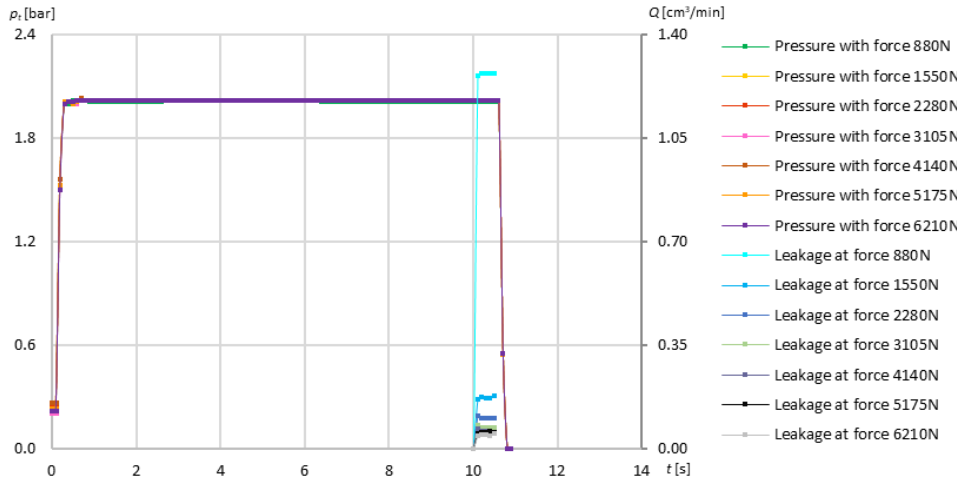
Figure 9. Graph of dependence for a pair of samples 9–10, produced with comparable surface topography parameters for different test cases, i.e., different compressive forces. Table 6. Forces and leakage of second pair